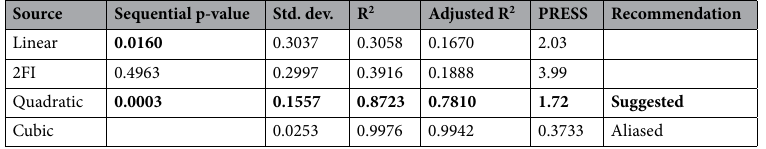
Table 4. Model summary statistics of wear rate for hot rolled steel. Significant values are in bold.